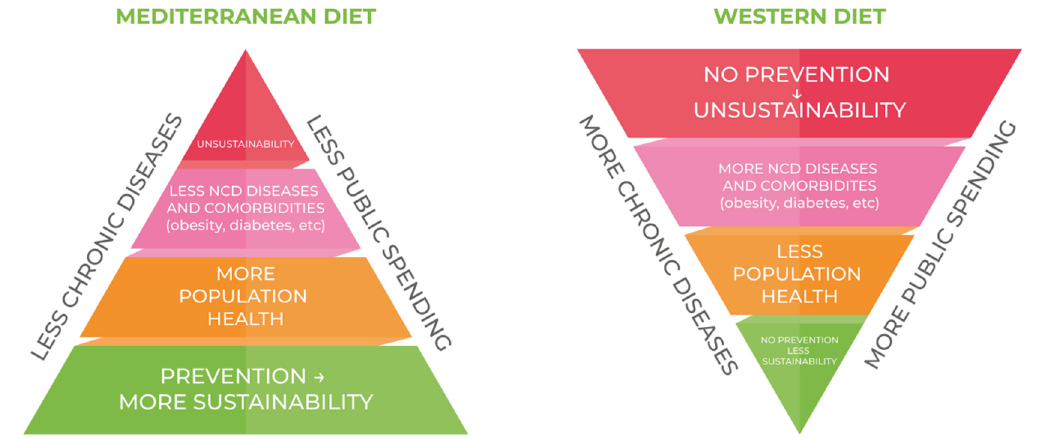
Figure 3. The consequences of the consumer’s daily choice.